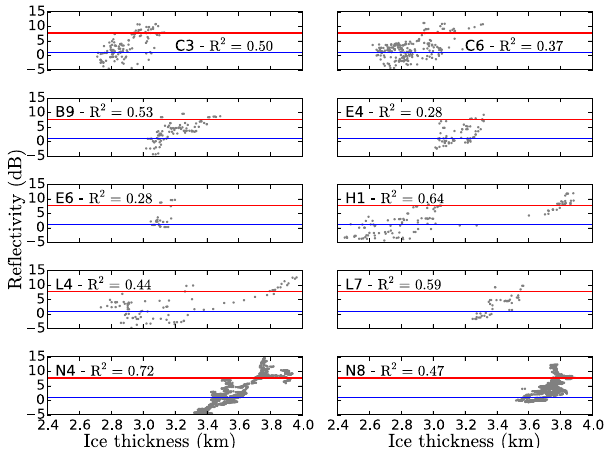
Figure 4. Basal reflectivity (dB) vs. ice thickness (km), at 10 favourable spots. Red and blue lines correspond to the thresh- olds of wet and dry